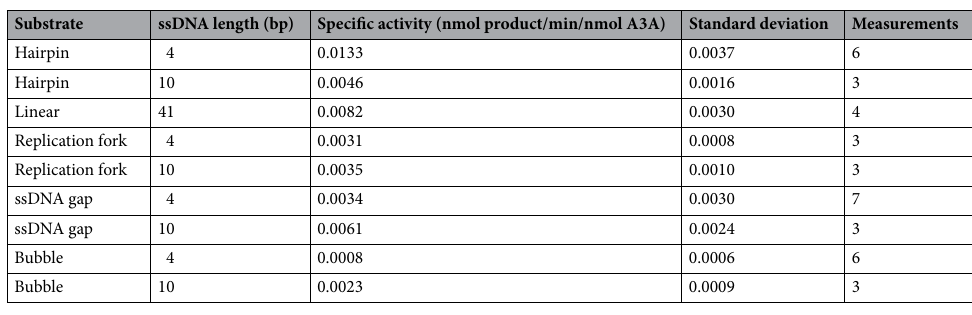
Table 1. Specific activities of A3A on various ssDNA